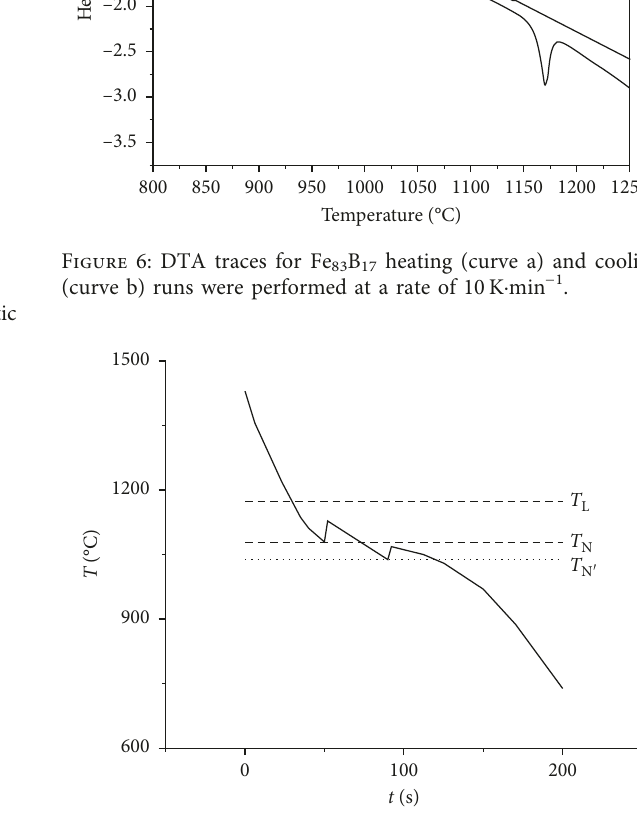
Figure 7: Typical cooling curves of Fe 87 B 13 sample prepared solidification